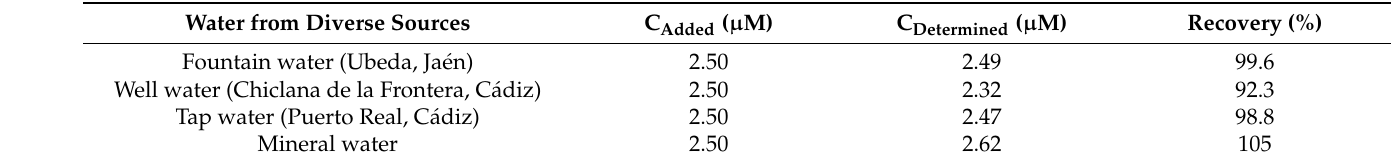
Table 2. Electrochemical determination of PCMC in spiked water samples collected from different areas of Andalusia (Spain).